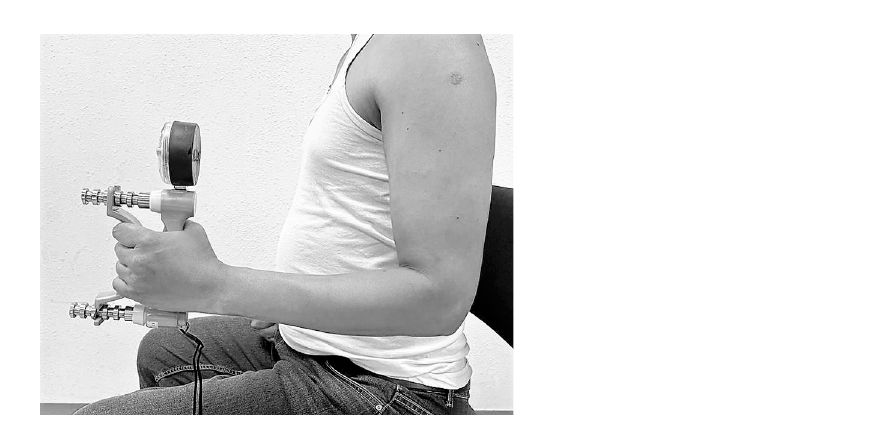
Fig 2. Handgrip strength evaluation using a handheld